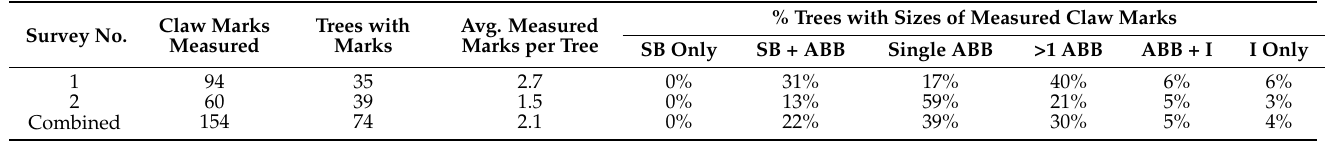
Table 1. Bear claw (climbing) marks found and measured on trees in Balpakram National Park, 2018–2022, and fitting the size of sun bears or Asiatic black bears. % Trees with Sizes of Measured Claw Marks Survey No. Claw Marks Measured Trees with Marks Avg. Measured Marks per Tree SB Only SB + ABB Single ABB >1 ABB ABB + I I Only 1 94 35 2.7 0% 60 39 1.5 154 74 2.1 0% 22% 39% 30%